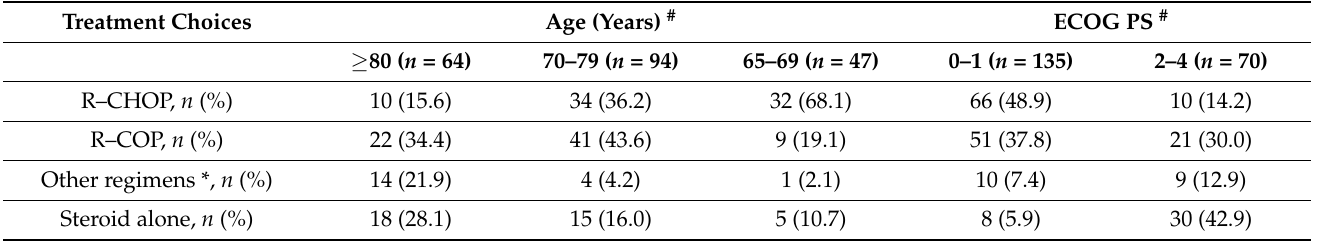
Table 2. Distribution of initial treatments stratified by age and performance status. Treatment Choices